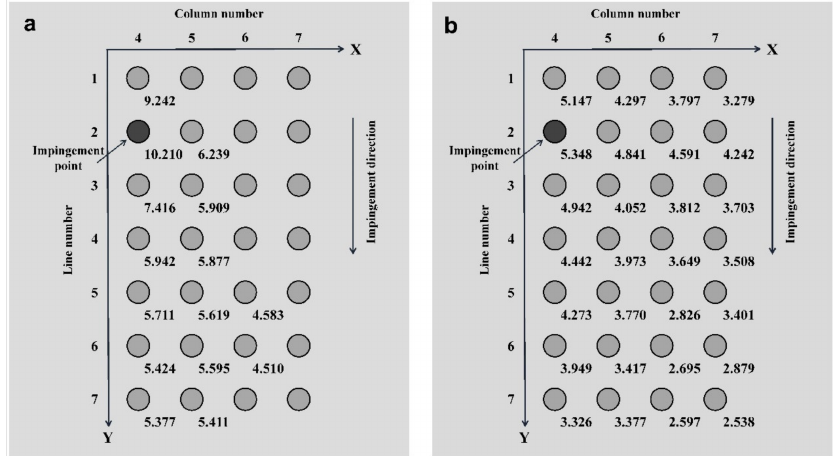
Figure 9. Distribution of current density (unit: µ A/cm 2 ) of 90/10 copper–nickel alloy wires in the WBE after 168 h impingement at 5 m/s using 1 wt.% NaCl solution ( a ) without and ( b ) with 0.2 wt.% sand particles.